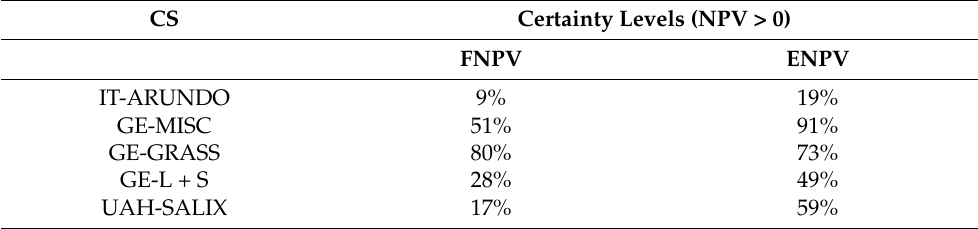
Figure 3. Overlay chart of Economic Internal Rate of Return (EIRR) of the selected investments. Table 7. Certainty levels by profitability indicator and